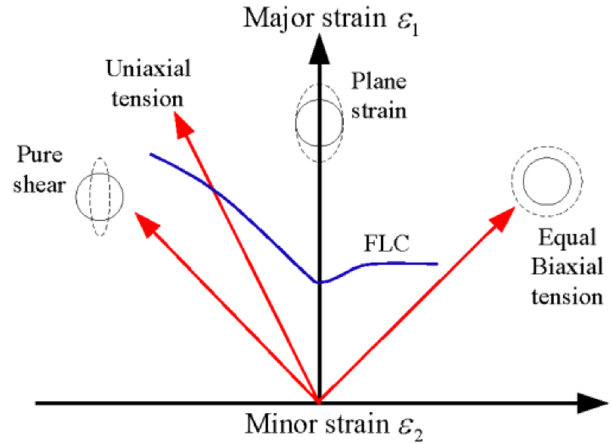
Fig. 1. Forming limit diagram [14].